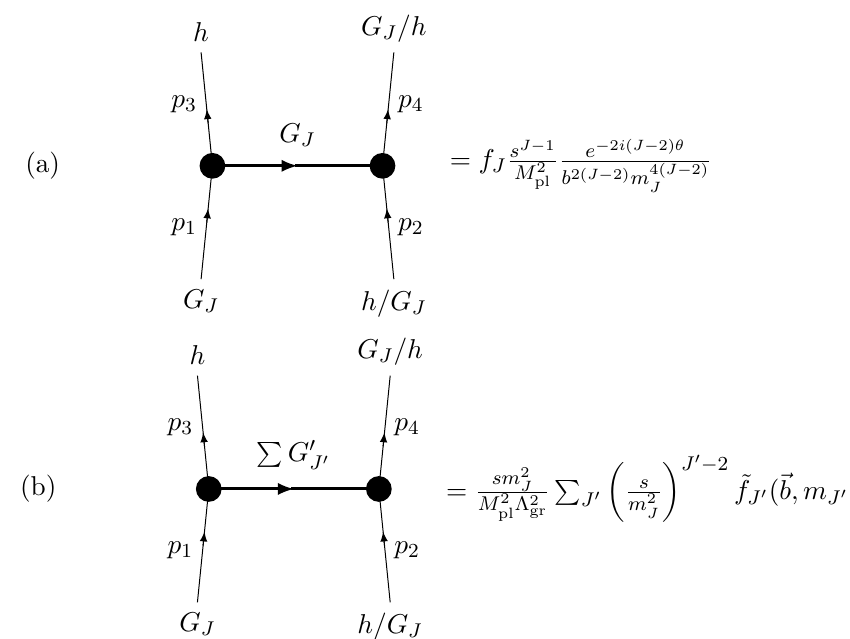
and δ hh come from the G - J GG Gh , an infinite tower of HS exchanges can contribute gr